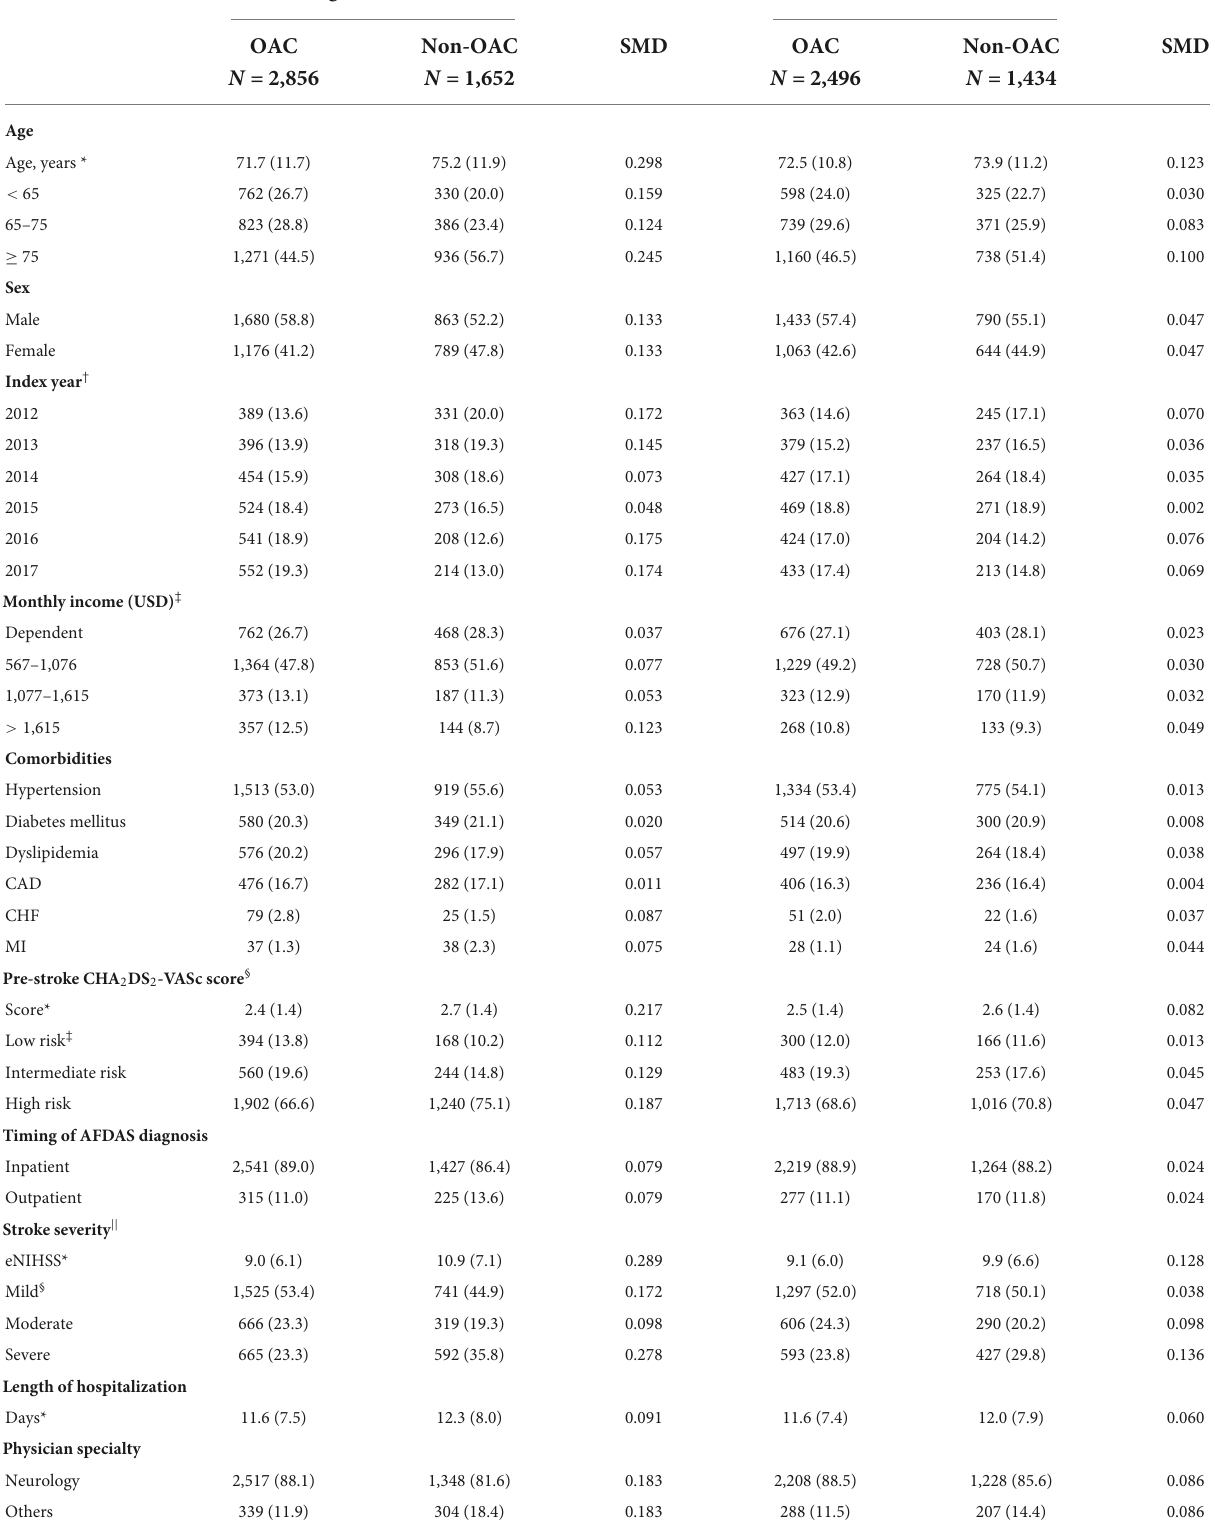
TABLE 1 Baseline characteristics before and after